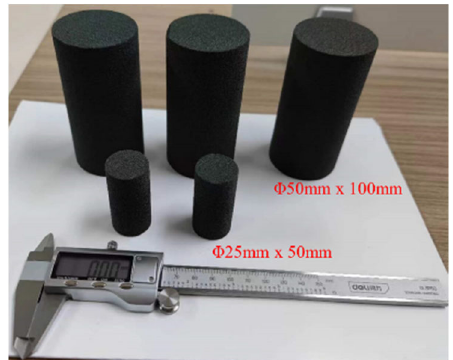
Figure 3. 3DP rock specimens of different sizes (The large cores and small cores are used for mechanical testing and microscopic structure characterization,